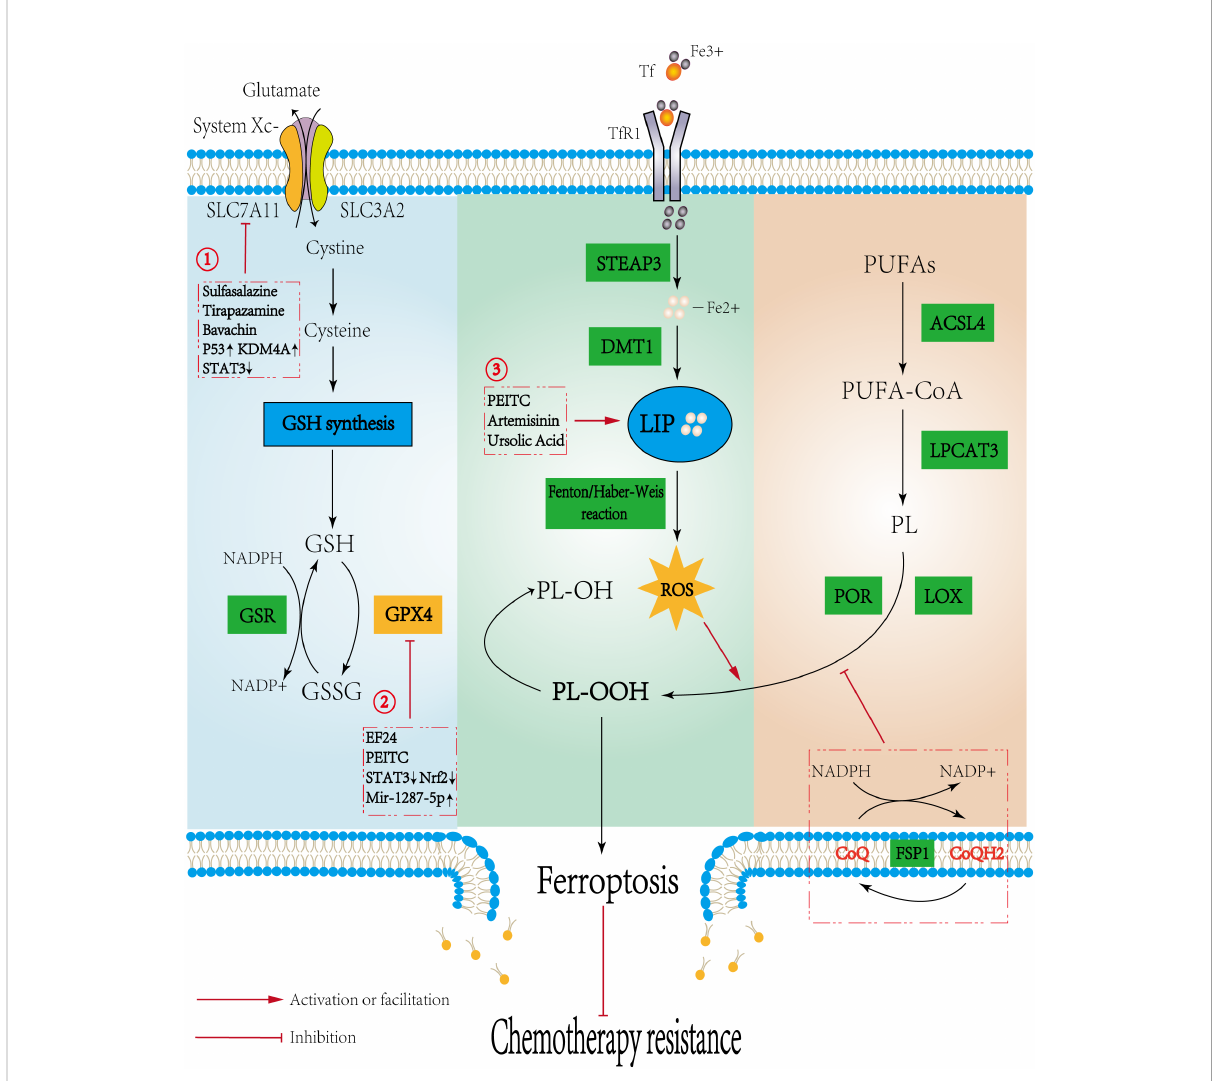
FIGURE 1 Mechanisms regulating ferroptosis and the potential role in osteosarcoma. Three pathways initiate the process of ferroptosis: the canonical GSH-GPX4 pathway, iron metabolism pathway, and lipid metabolism pathway. The Potential mechanisms of ferroptosis in osteosarcoma are as follows: 1. Sulfasalazine, Tirapazamine, and Upregulating P53 or KDM4A could promote ferroptosis by directly inhibiting the activity of SLC7A11. Bavachin indirectly reduces SLC7A11 expression by downregulating STAT3 to upregulate P53 expression. 2. EF24 and PEITC, upregulating Mir- 1287-5p and inhibiting STAT3/Nrf2 signaling pathway could inhibit GPX4 to induce ferroptosis; 3. PEITC, Artemisinin, and Ursolic acid induce ferroptosis by increasing Fe 2+ within the LIP. Promoting ferroptosis reduces chemotherapy